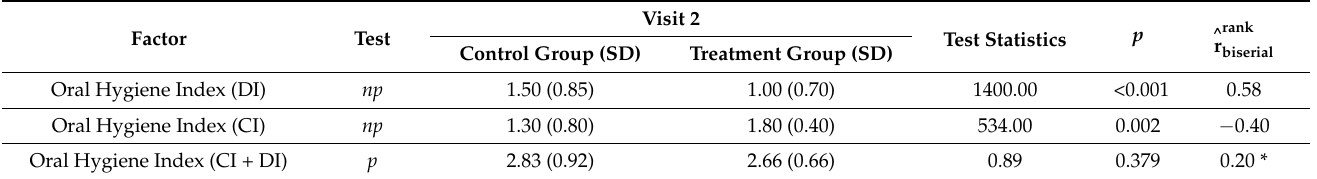
Figure 1. Approximal plaque index vs. Group variable with differences in means statistical reporting. Statistically significant differences were also observed in OHI-S Index values and 1 out of 2 components (CI) (Table 2). Table 2. Estimating the differences in means for two independent samples for OHI-S Index and its